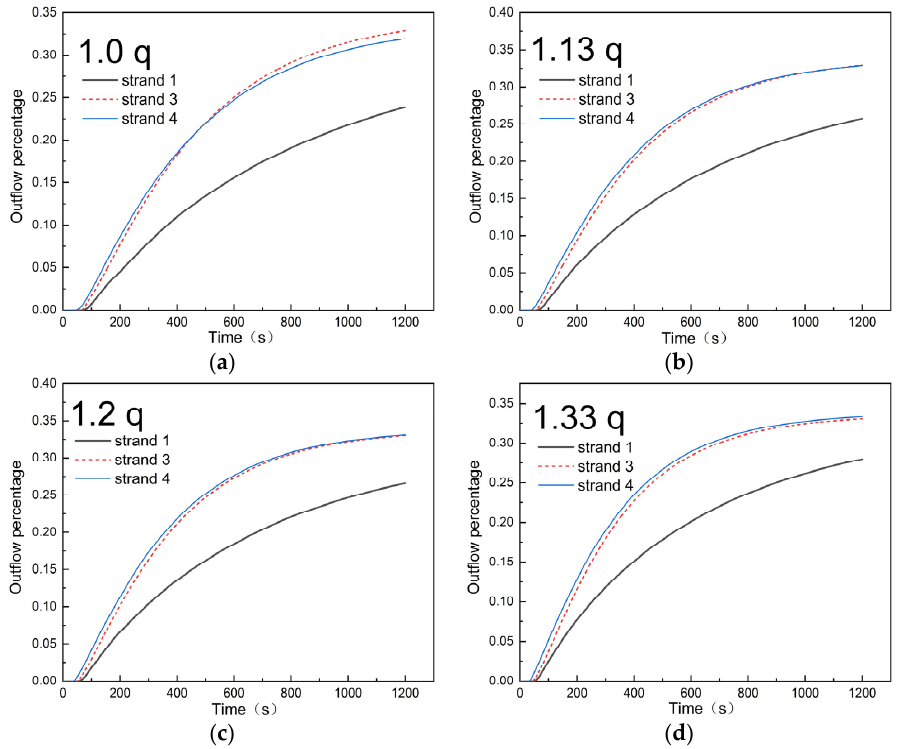
Figure 15. Outflow percentage curve of the double-weir tundish with uniform increasing casting flow rate under strand 2 blockage condition: ( a ) 1.0 q, ( b ) 1.13 q, ( c ) 1.20 q, ( d ) 1.33 q.